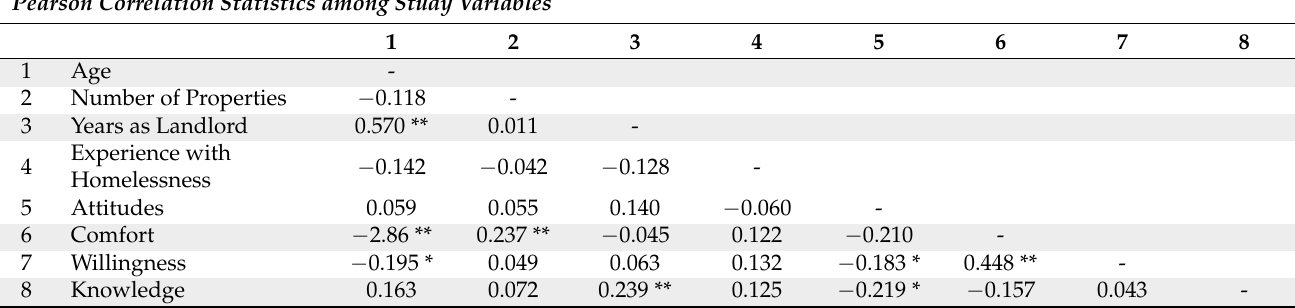
Table 3. Correlation statistics. This table provides the Pearson correlations among the independent and dependent variables in the